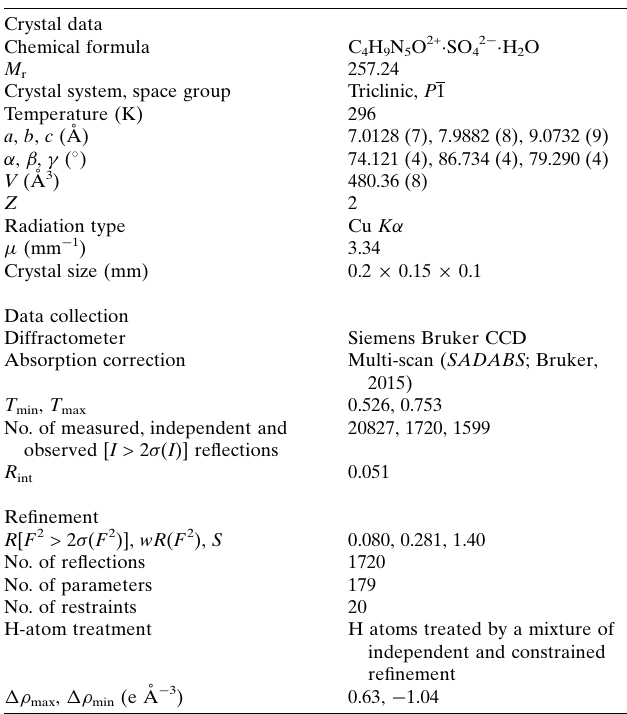
Table 2 Experimental details. Crystal data Chemical